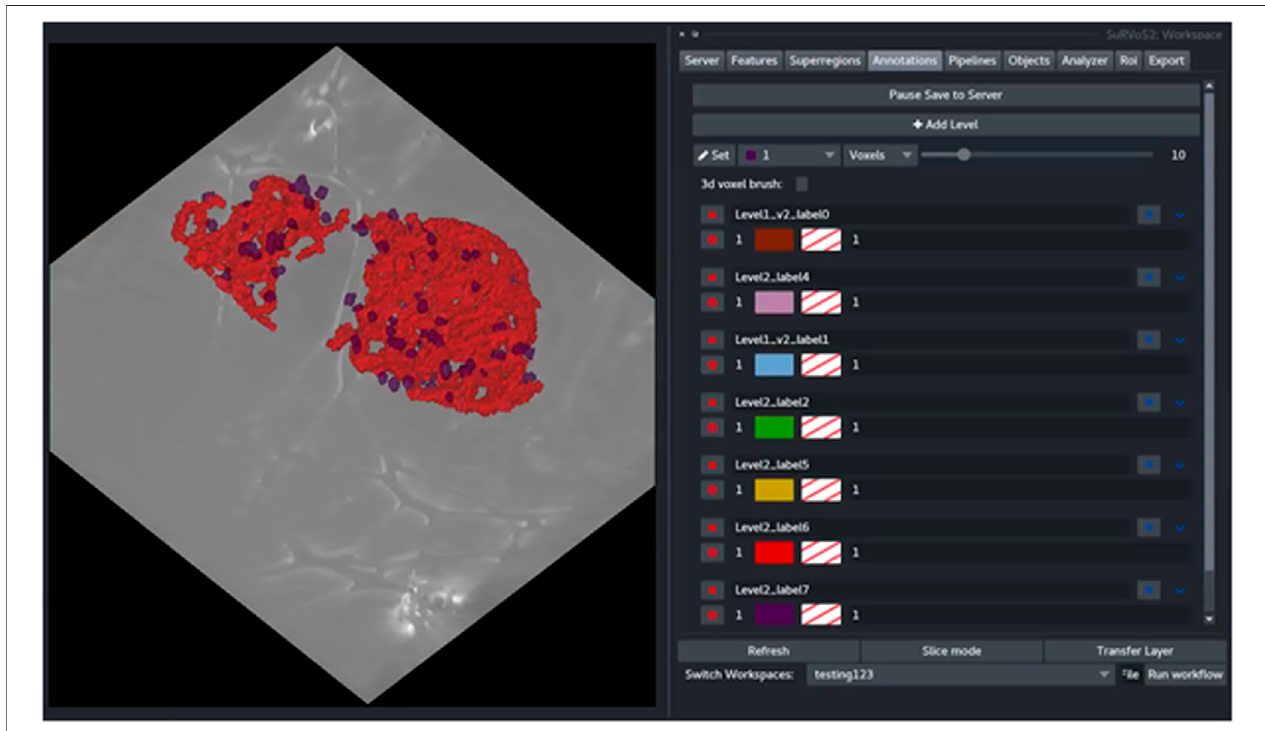
FIGURE 5 | The output of the Label Splitter can be visualized as annotation layers within the SuRVoS2 plugin. Rules are applied sequentially to all selected objects and after splitting, each new class can be visualized and given a unique label and color.